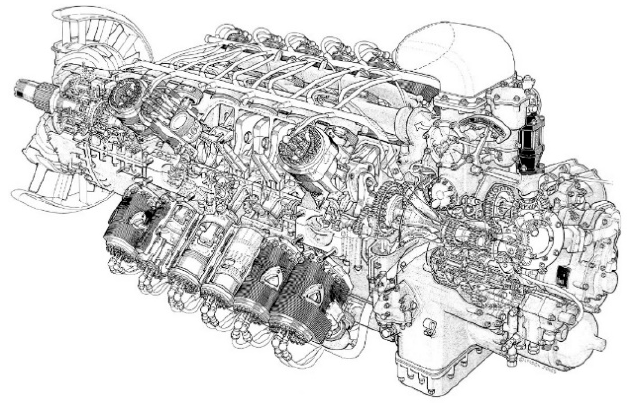
Figure 17. E.E.K. Sparmann 26 November 1946, two-cycle engine sleeve valve control of scaveng-